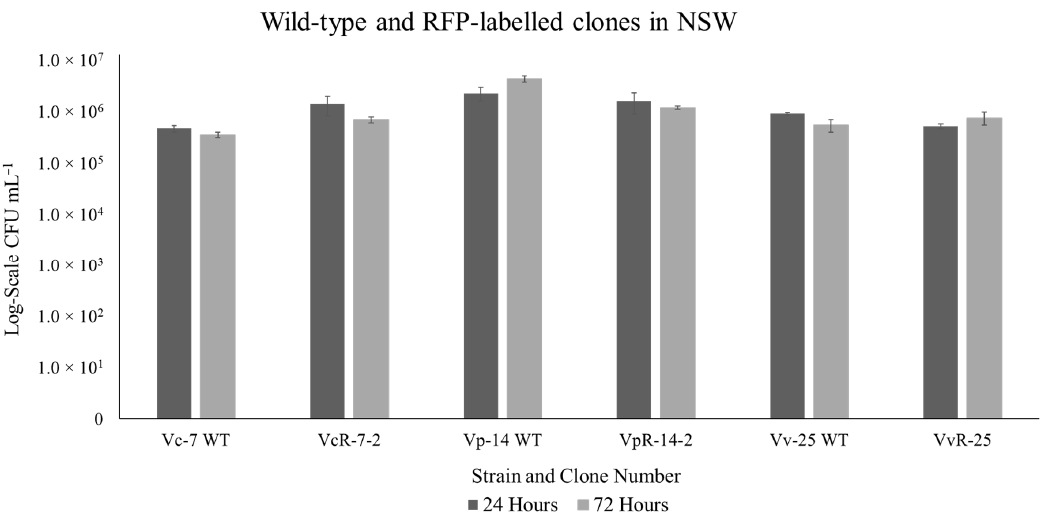
Figure 7. The stability of RFP-labelled Vibrio clones in sterile North Sea Water (NSW). Over 72 h, the RFP-tagged clones were tested in comparison to the corresponding wild-type (WT) strain. The CFU was enumerated on MB agar for the WT bacteria and MB agar supplemented with 50 μ g mL − 1 gentamycin for the RFP-tagged clone after 24 h (dark grey) and 72 h incubation (light grey) at 28 °C in sterile NSW.